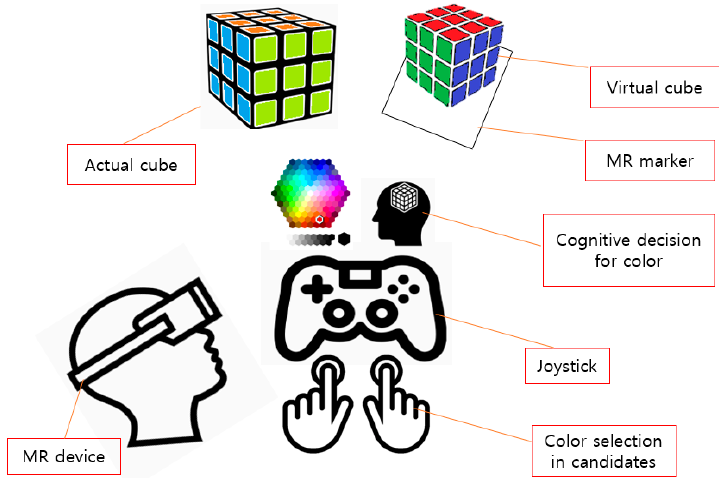
Figure 11. Experimental task of selecting a color parameter for the virtual cube, compared with the actual cube. In the experiment, the subject was asked to match the color of the actual cube. In the first frame, the virtual cube was presented with different color values, and participants were able to select the same color with their cognitive decision among candidates which consisted of a set of similar colors. In the experiment, participants select one from seven colors (each cube face) and they could go back for their choice with the controller. Enough time was given until the participant’s choice was made.